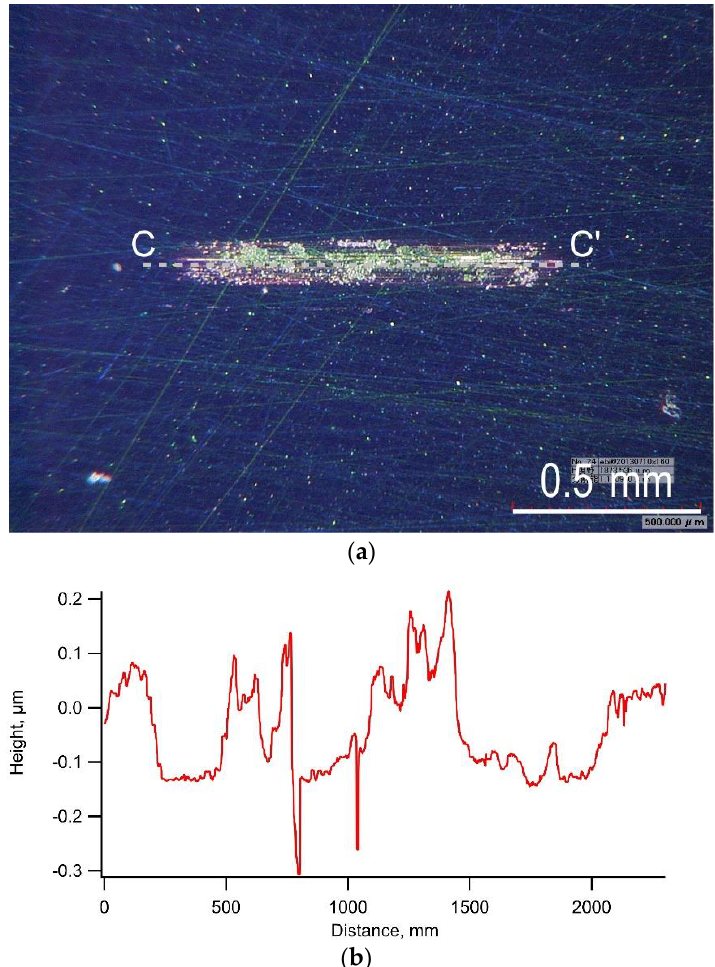
Figure 8. Typical example of the appearance of wear scar and its cross-section shape observed in the test using ta-C film: ( a ) Appearance of wear scar on test plate , ( b ) Cross-section shape along C-